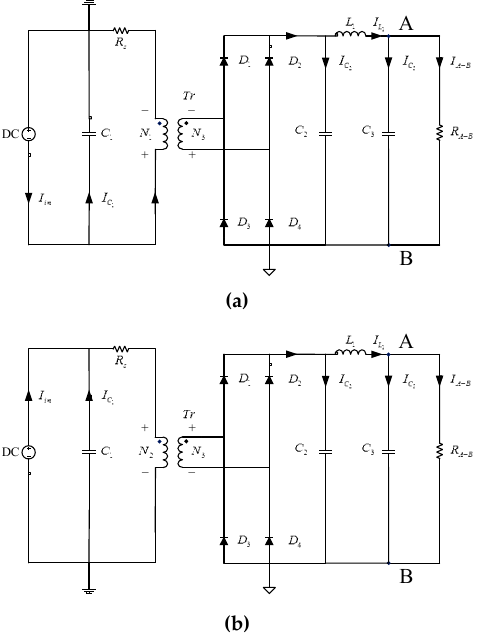
Figure 6. Equivalent circuit diagram of closed status of constant current isolation circuit: ( a ) Equivalent circuit diagram during t 1 ∼ t 2 period; ( b ) equivalent circuit diagram during t 3 ∼ t 4 period.